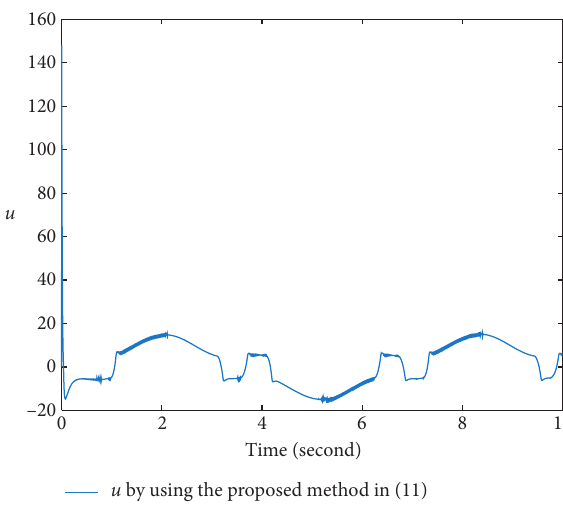
Figure 7: Trajectory of u by using the proposed method in